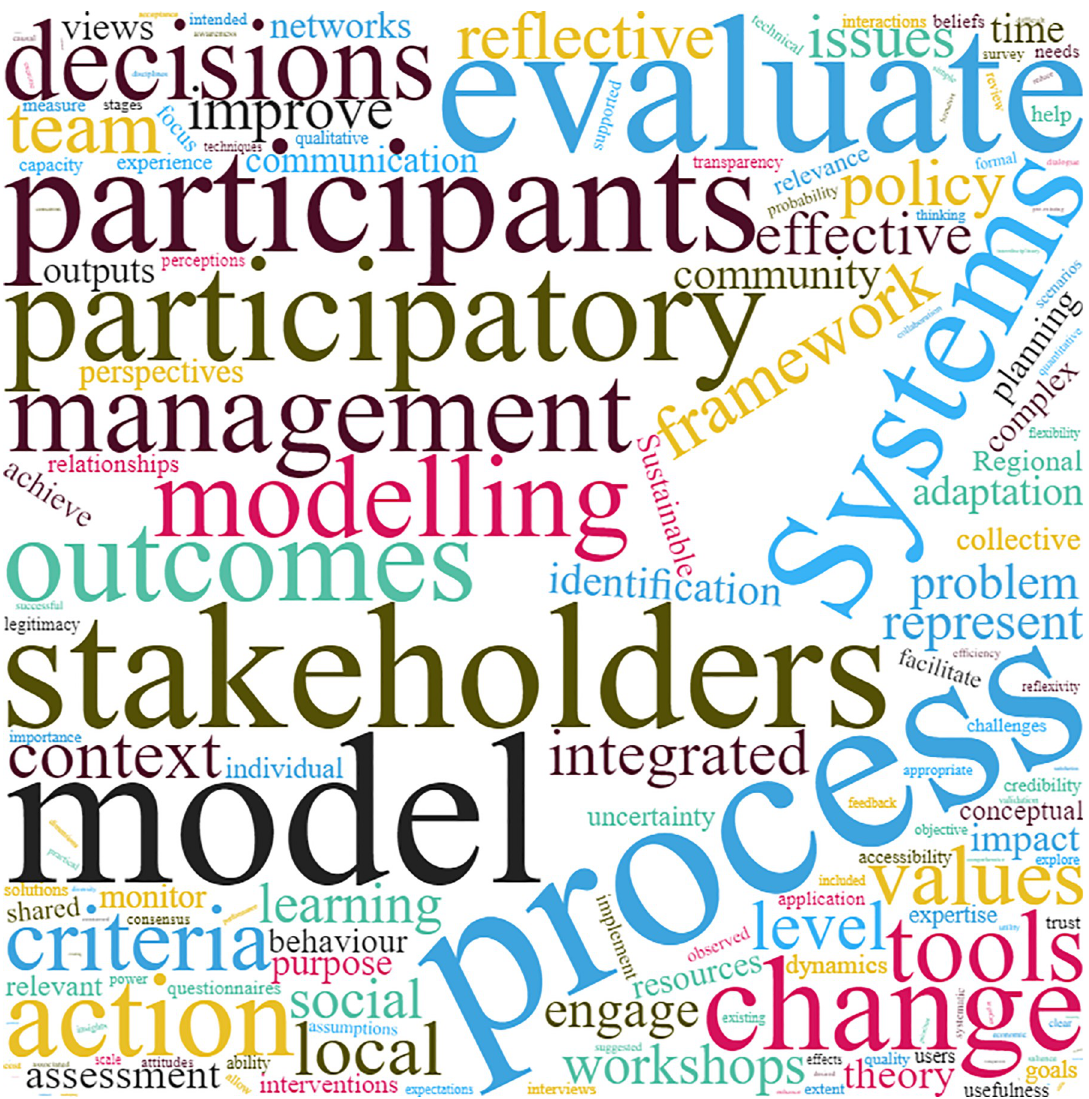
Fig 2. Word cloud generated by uploading the full text of all studies included for